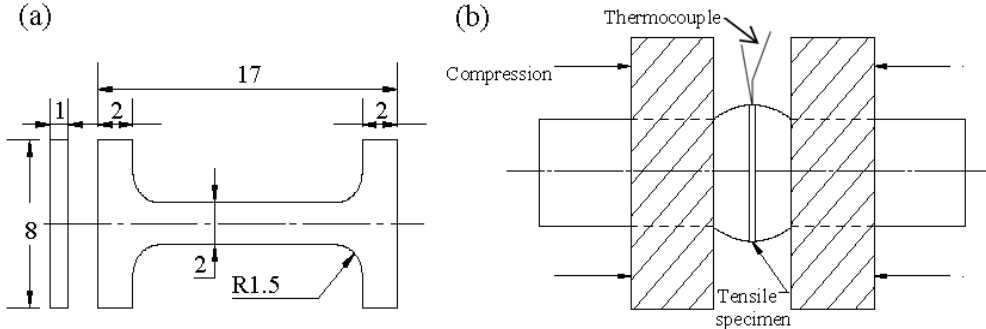
Figure 2. Wire-cut tensile sample ( a ) (in mm) from the cross section of TMCP simulation specimen ( b ) with 10 × 2 mm 2 gauge length located in the center of the formerly compressed section.